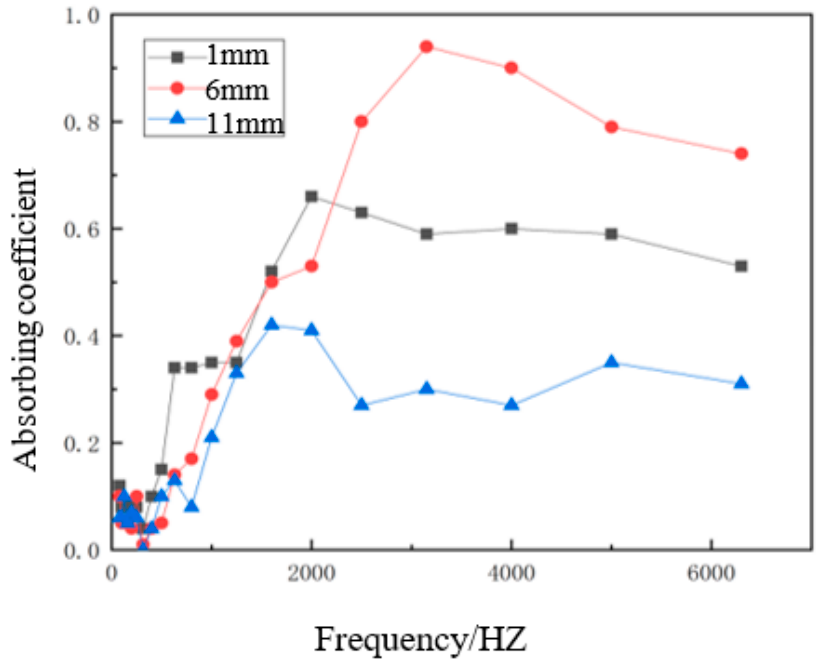
Figure 7. Sound absorption coefficient curves for different hemp stalk lengths.